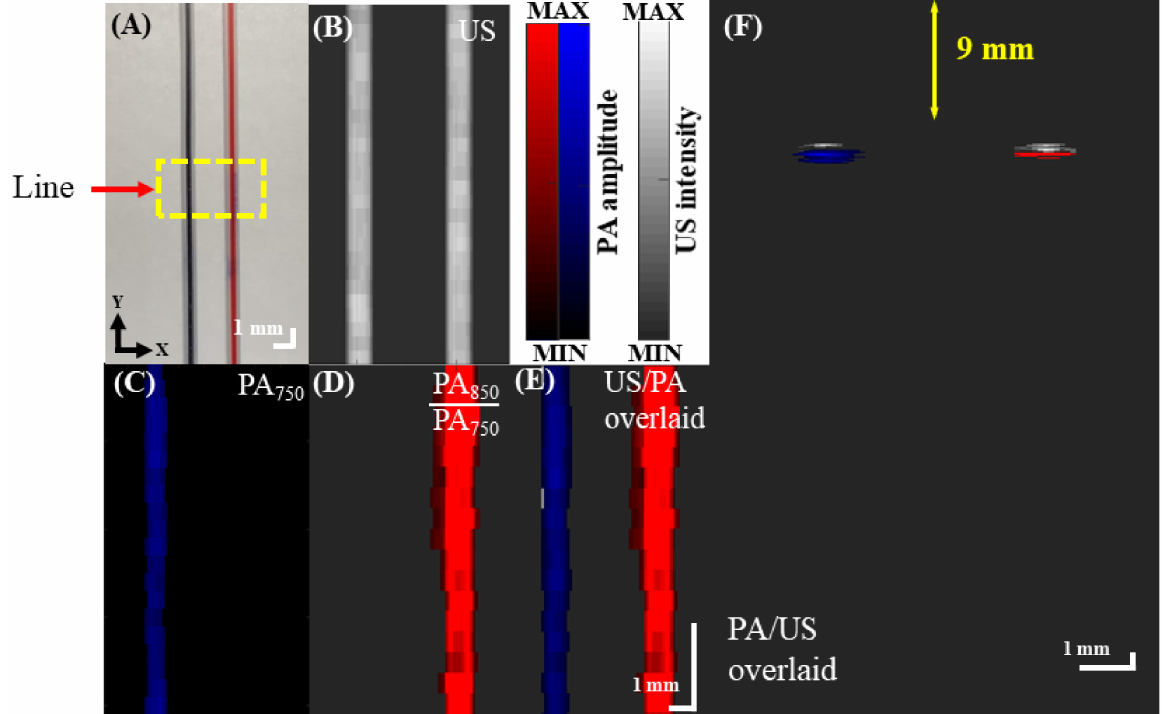
Figure 7. US/PA imaging of blue and red inks in the vasculature-mimicking phantom. ( A ) US/PA imaging of a rectangular region (6 × 12.695 mm 2 ) indicated by yellow dashed lines of the phantom. MAP images from ( B ) US scanning of the tubes and ( C ) PA imaging of the ink-filled tubes at a 750 nm laser wavelength. ( D ) Proportional PA MAP image (PA 850 /PA 750 ) of the phantom. The C-scan was acquired with a 0.1 mm step size and a 2 mm/s speed. ( E ) Combined overlaid US/PA MAP image of the ink-filled tubes. US: ultrasound; PA: photoacoustic; PA 750 : PA signal at a 750 nm excitation wavelength; PA 850 : PA signal at an 850 nm excitation wavelength; MAP: maximum amplitude projection. ( F ) Overlaid US/PA B-scan image of the ink-filled tube phantom at the position labeled “line” in ( A